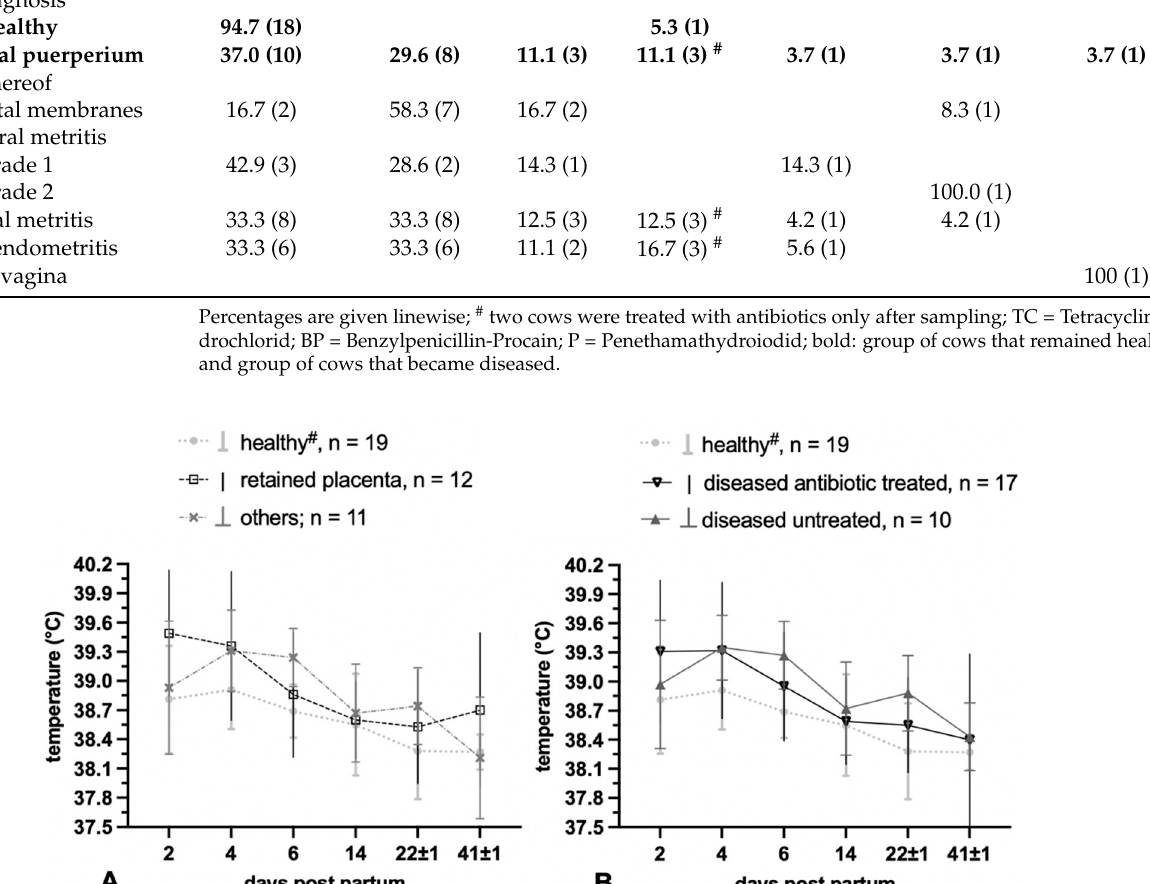
Table 3. Treatments with antibiotics over the study period. TC was applied locally in the uterus (6000 mg three times at two-day intervals) BP (7500 mg twice at 24-hour intervals) and P (5000 mg daily for three days) were injected into the muscle.